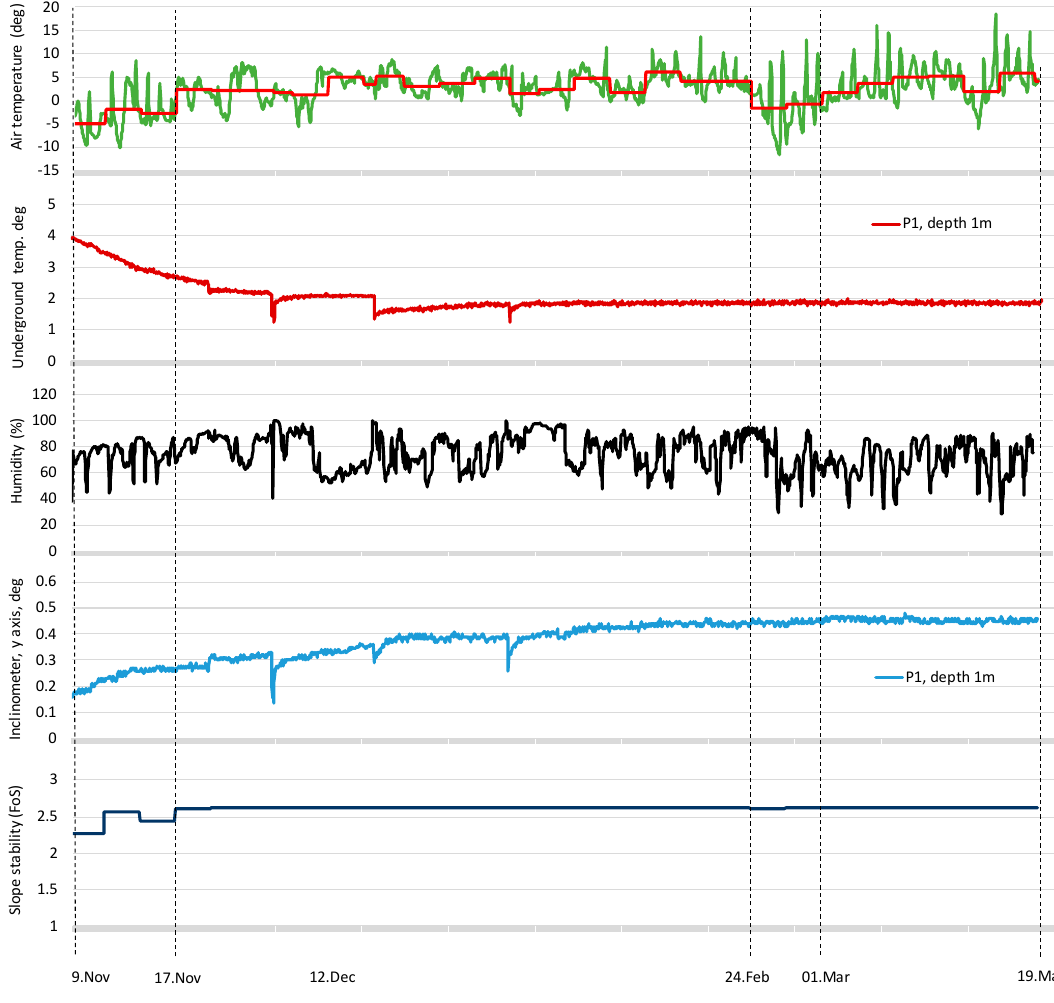
Figure 13. Slope stability analysis with measured data from test slope at Øysand site, Norway.